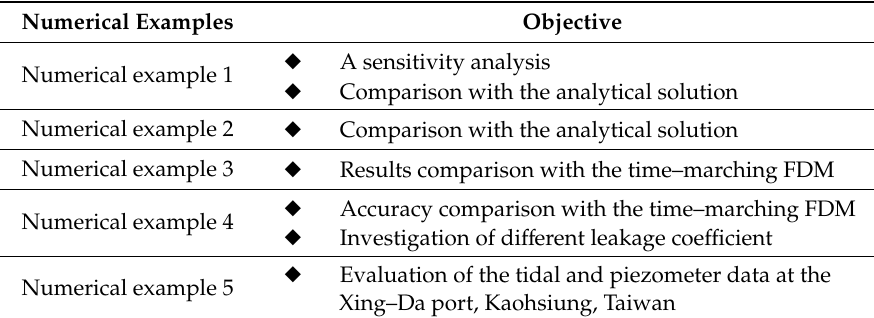
Table 1. The objective of each numerical